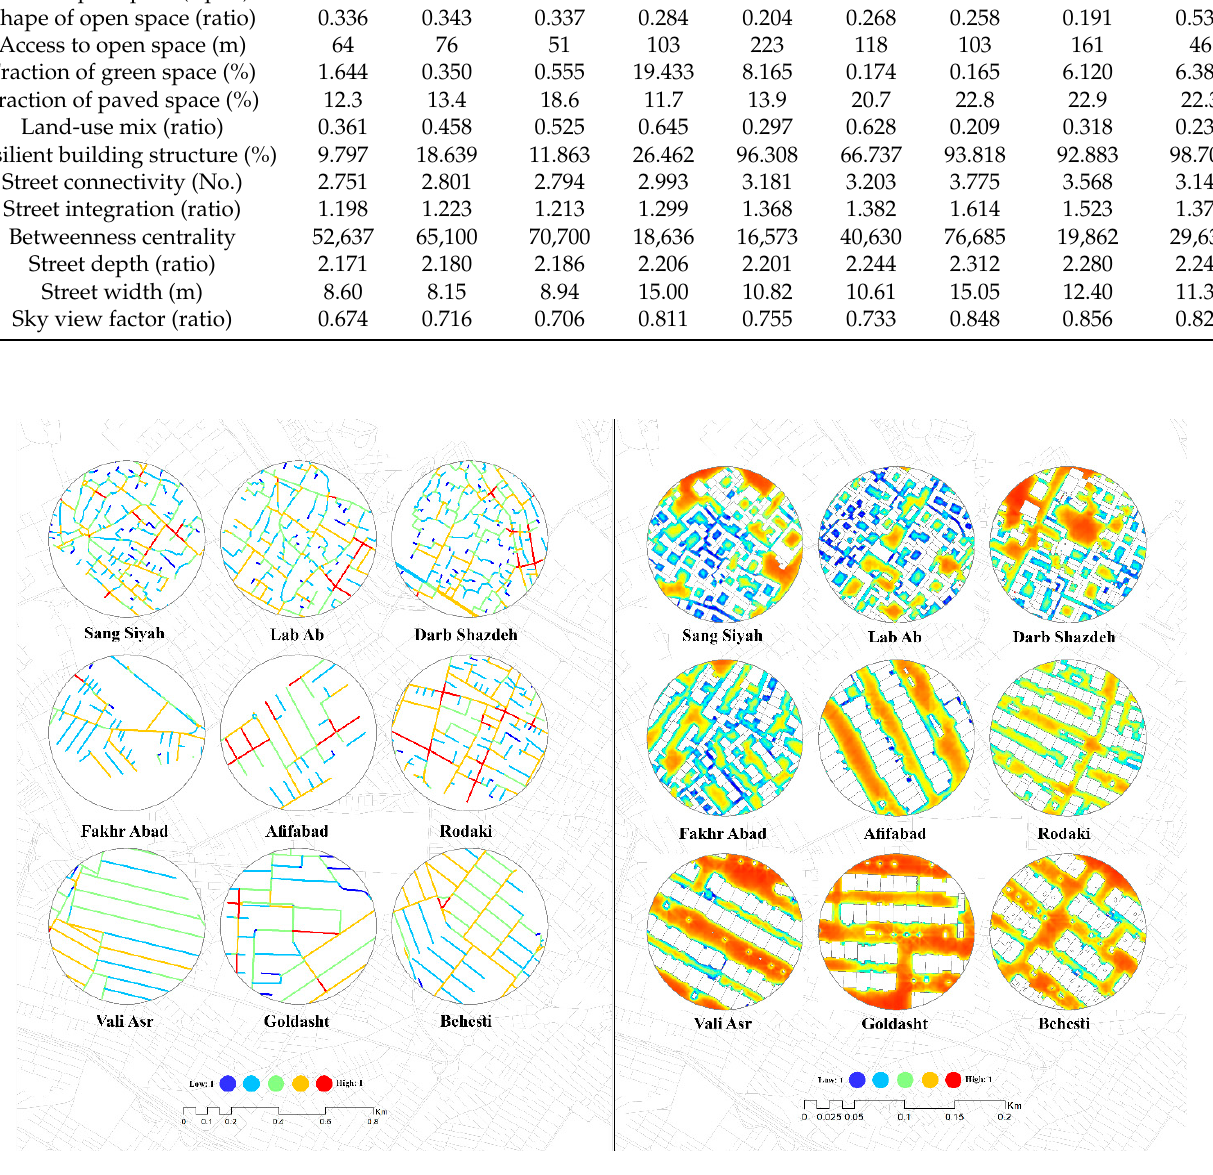
Figure 4. The state of connectivity ( left ) and sky view factor ( right ) in the selected neighborhoods.